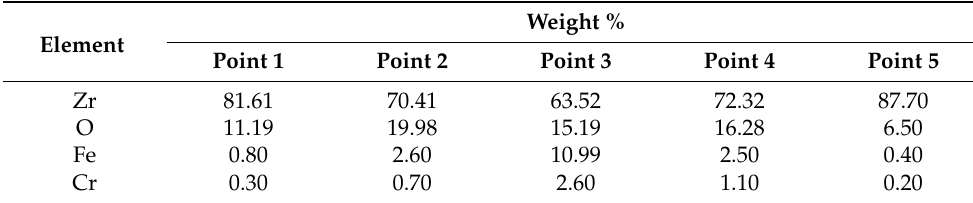
Table 3. The chemical compositions of points in